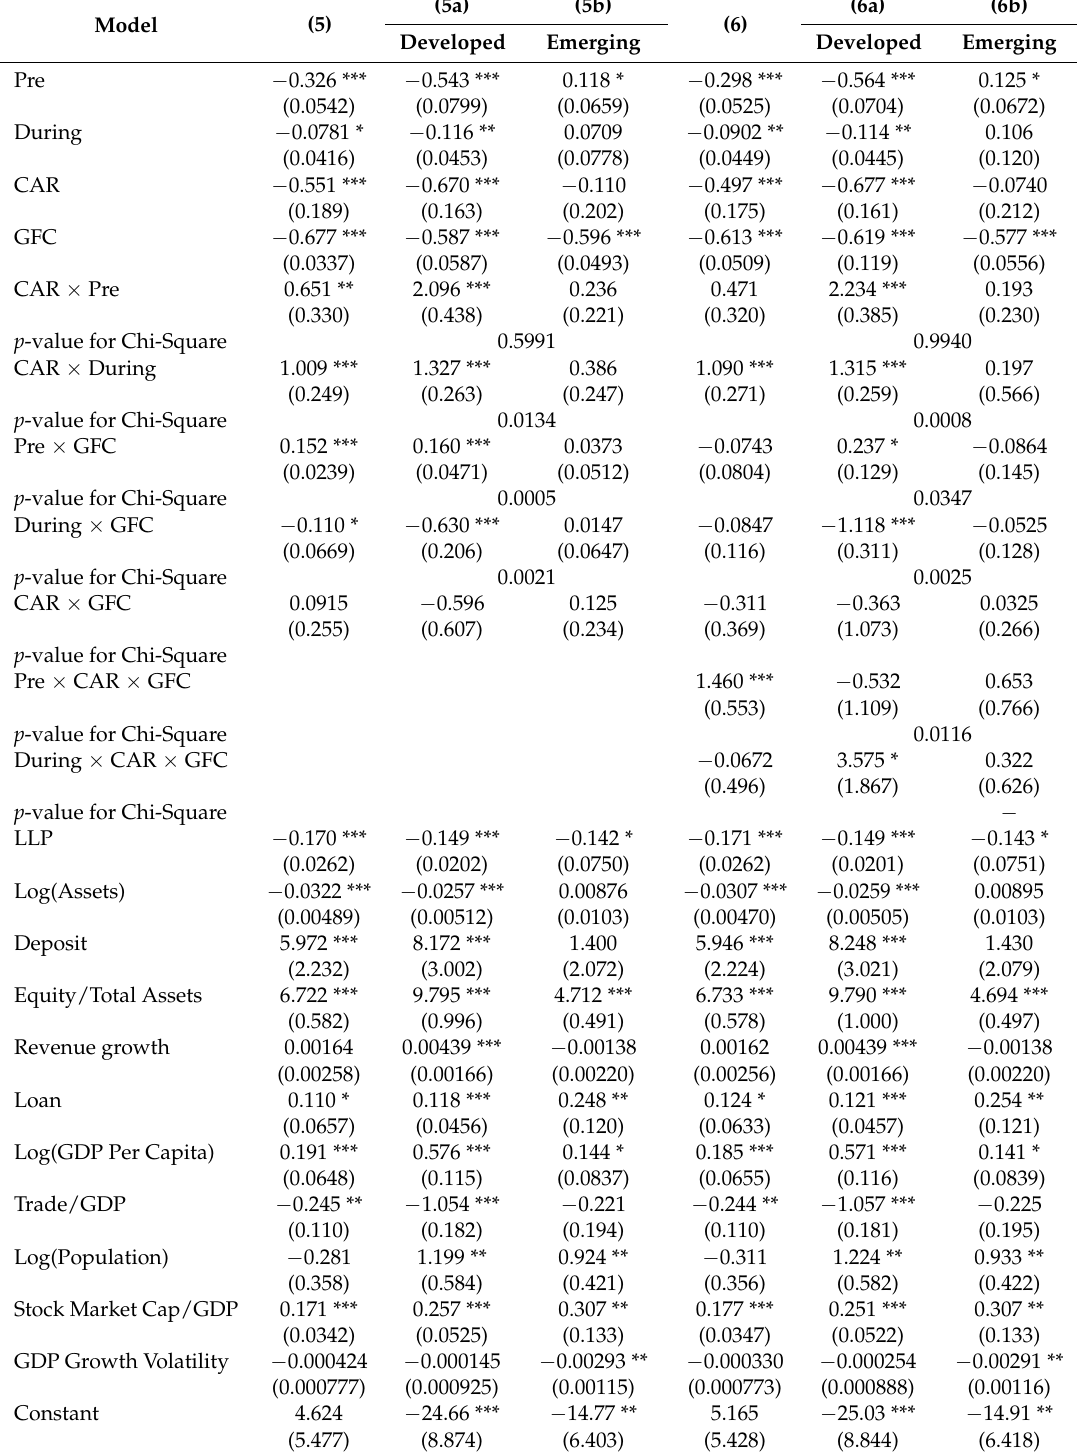
Table 5. The immediate effect of reduction in deposit insurance, capital adequacy and bank